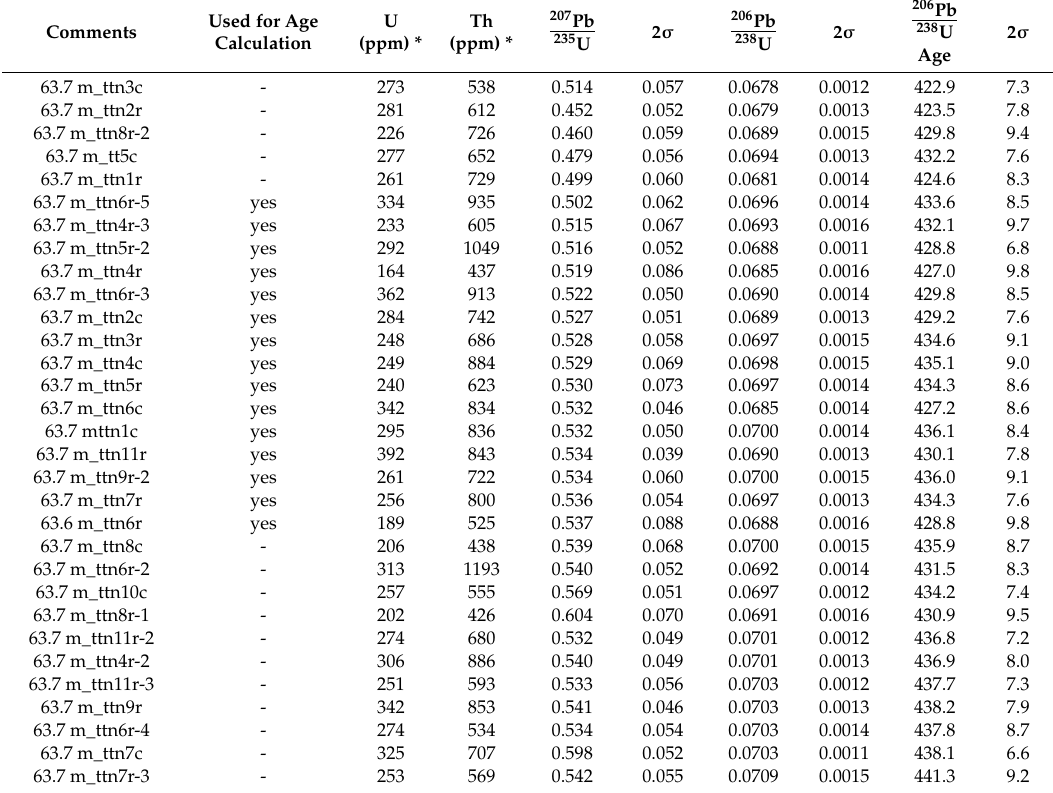
Table 2. Laser ablation data from the analysis of titanite in sample from drill core SB0806 at 63.7 m.